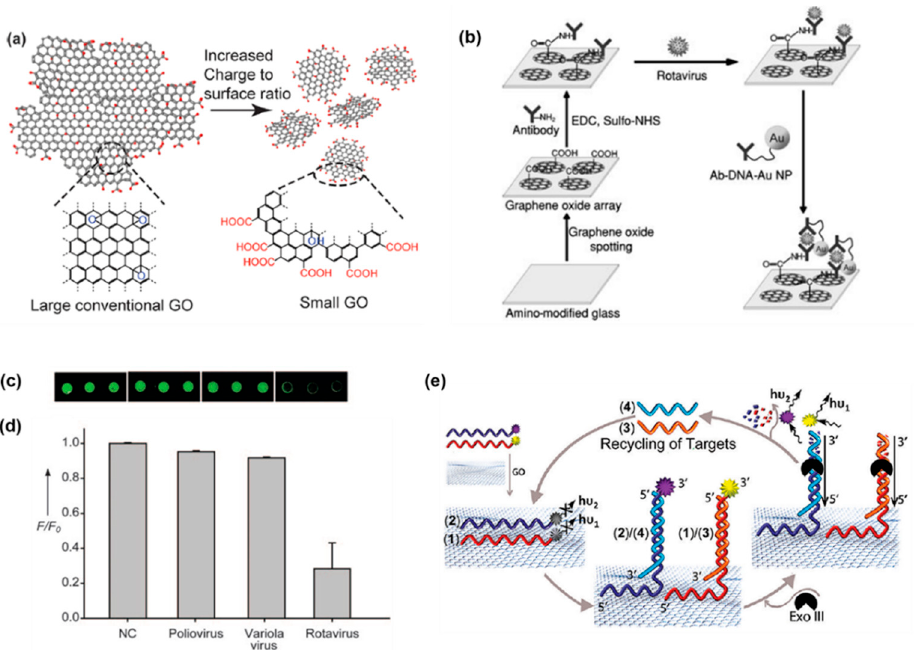
Figure 3. ( a ) Conventional GO and nGO used as artificial protein receptor exhibiting OCG on the edges which are binding sites for biomolecules. ( b ) Nano GO-based immuno-biosensor. ( c ) Nano GO-based immune-biosensor. Fluorescence signals of the negative control (NC), poliovirus, and variola virus were similar. The fluorescence signal of the rotavirus was significantly reduced. ( d ) Quantitative data showing that the fluorescence quenching effect caused by the target rotavirus was 15 times higher. ( e ) Exo III-induced recycling analytes that amplify sensing signals and the multiplexed analysis on GO platform. Reprinted with permission from References [75,79,83].